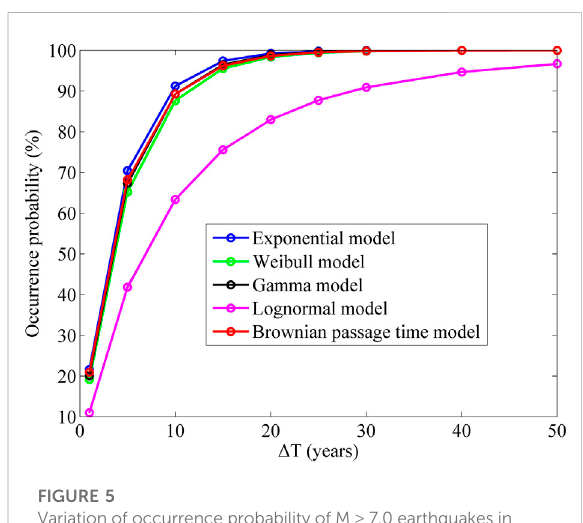
FIGURE 5 Variation of occurrence probability of M ≥ 7.0 earthquakes in Taiwan with time calculated based on fi ve statistical distribution models.